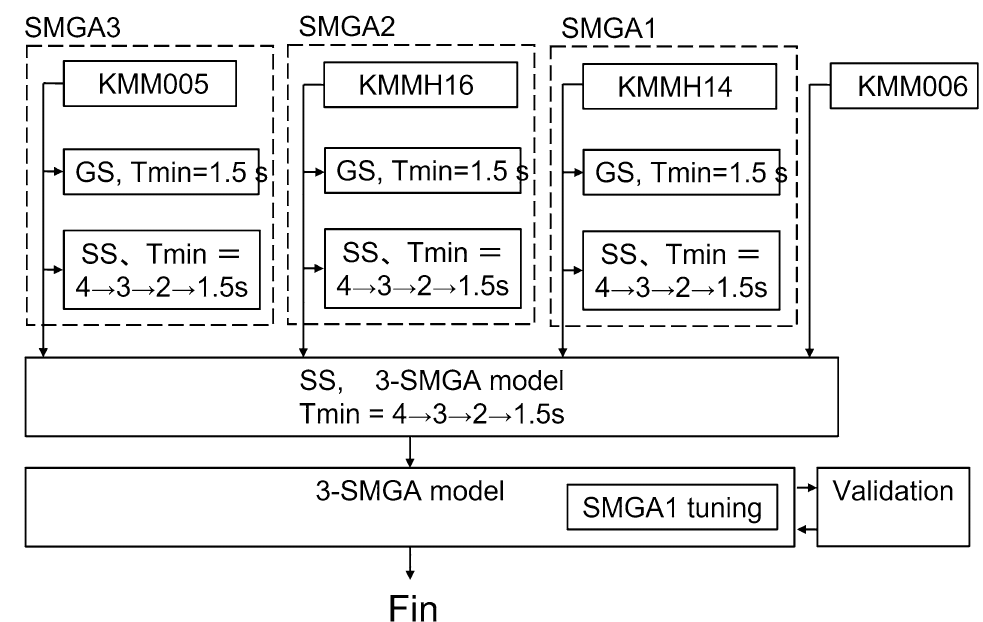
Fig. 5 Flowchart of the inversion method. GS—grid search, SS – simplex search